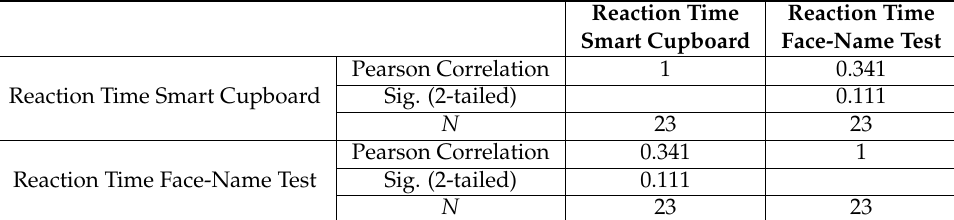
Figure 11. Comparison between the SC reaction time and the reaction time of the face–name test. Table 4. Correlation between the SC reaction time and the reaction time of the face–name test.